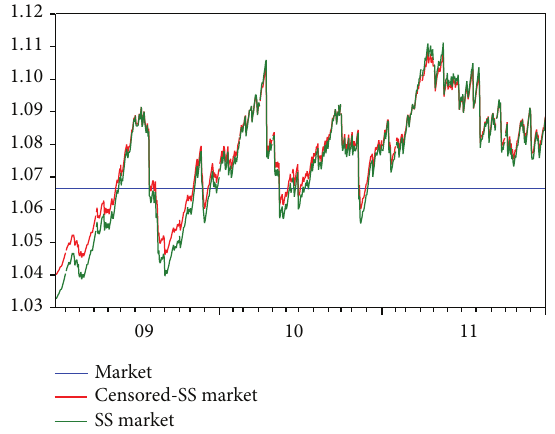
Figure 3: Beta sequences of large corporations combination.